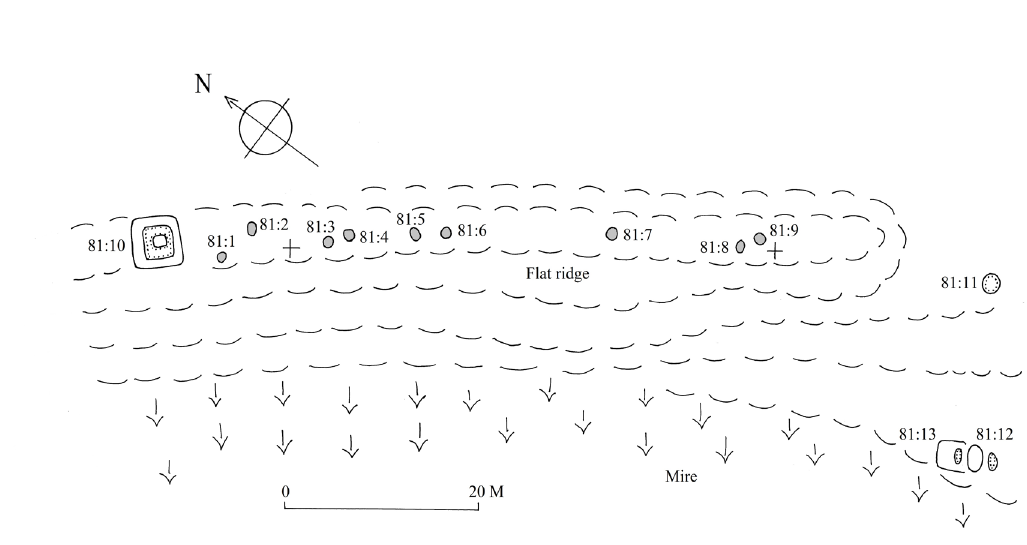
Figure 10. NHB 81 Hortlax parish: 81:1-9 hearths, 81:10 hut ruin, 81:11 pit, 81:12 cellar, 81:13 place for a storage